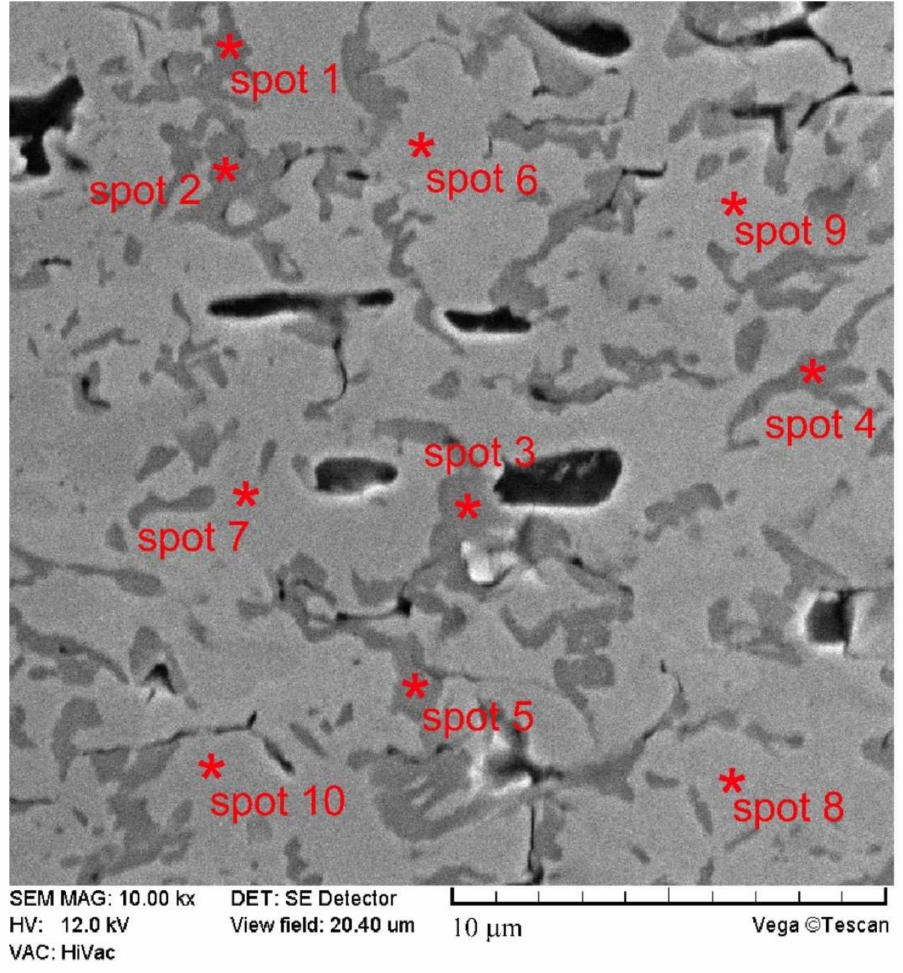
Figure 3. SEM microstructure of the gas-borided Inconel 600-alloy with marked spots in which EDS point microanalysis was performed and results of EDS point microanalysis; *—marking the exact point of the measurement; spots 1–5—the measurements carried out in the chromium borides mixture; spots 6–10—the measurements carried out in the nickel borides